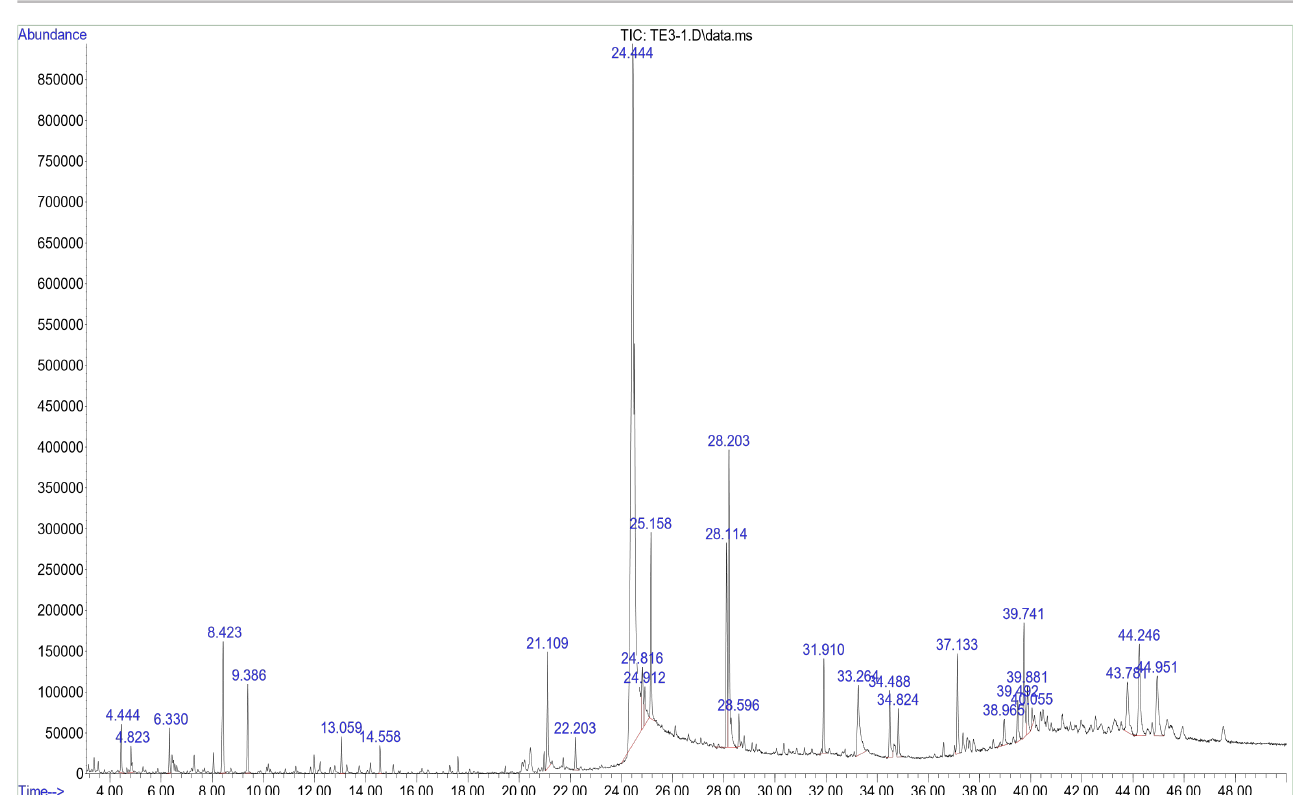
FIGURE 3 - GC-MS chromatogram of the TE3 fraction of ethyl acetate